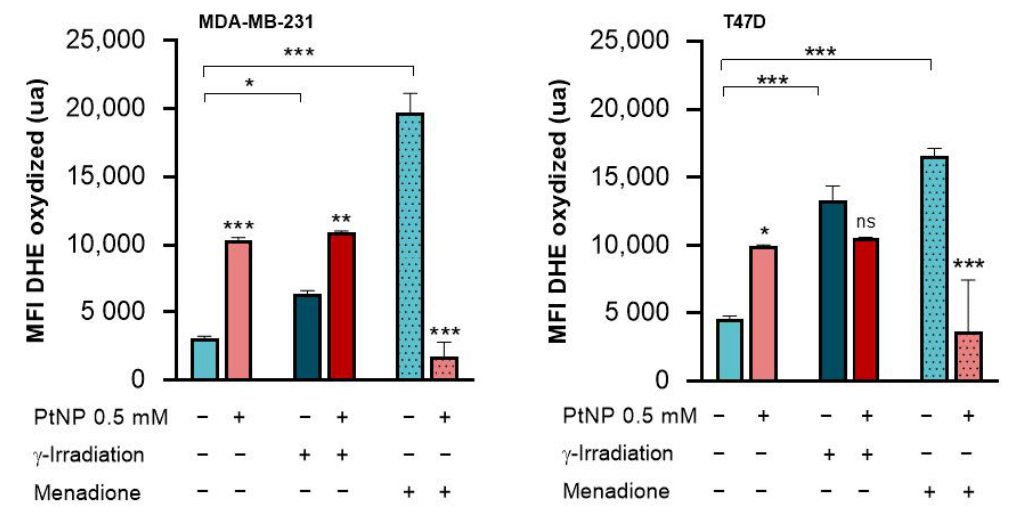
Figure 5. ROS quantification in breast cancer cells exposed to 0.5 mM PtNPs or not and further irradiated or treated with menadione. The fluorescence emitted by the oxidized DHE probe was measured for the MDA-MB-231 and T47D cell cultures, after exposure to PtNPs and/or irradiation with 6 Gy. The two last columns of each graph represent the fluorescent signals obtained with an incubation with menadione, an inducer of oxidative stress. For each condition, 4 replicates were analyzed. Note: ns = non-significant; * p < 0.05, ** p < 0.01, and *** p < 0.001.